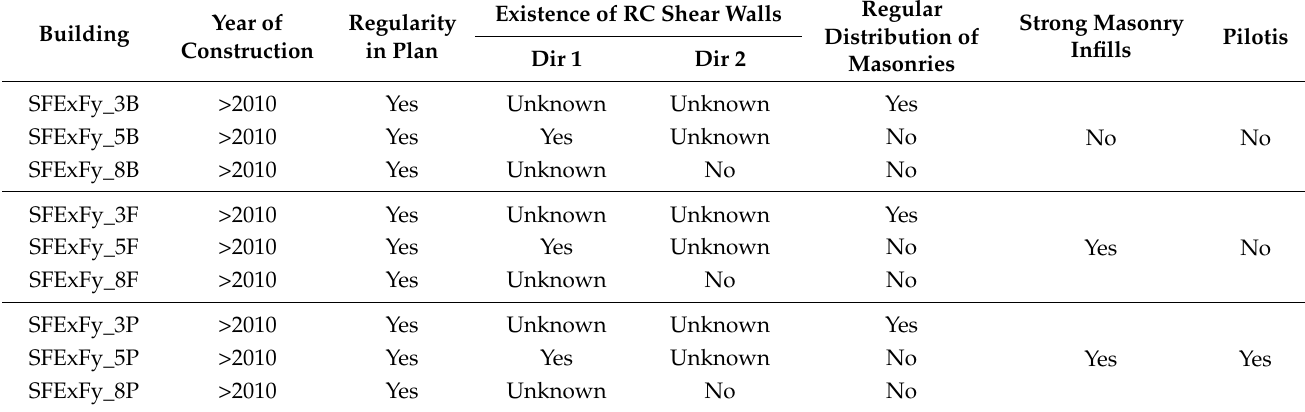
Table 10. Structural data of the three versions of the three case study